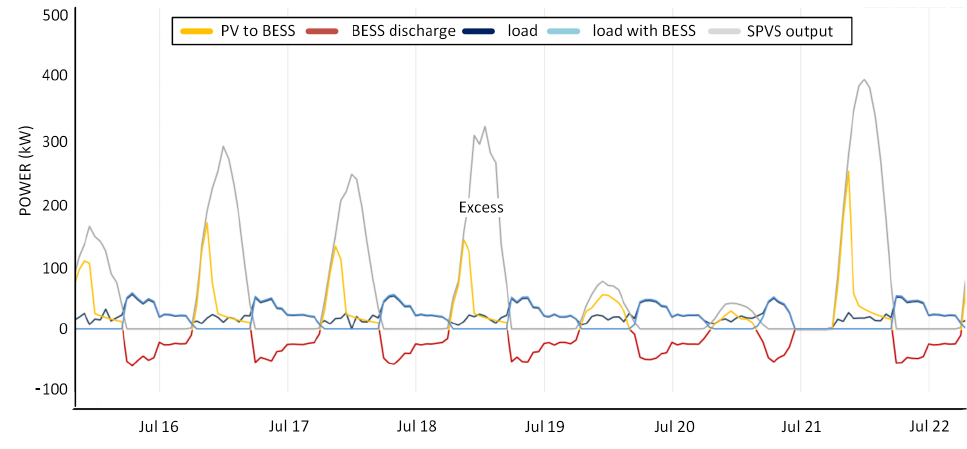
Figure 10. Power distribution from CWEEI during several days of July.